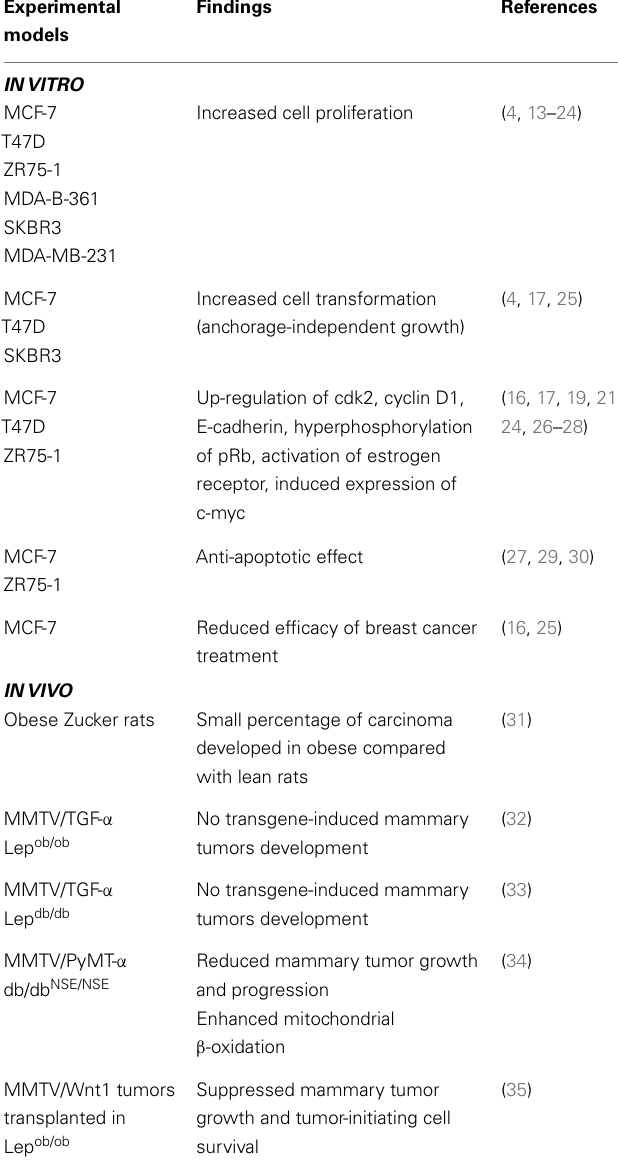
Table 1 | Role of leptin in breast cancer growth and progression: in vitro and in vivo studies